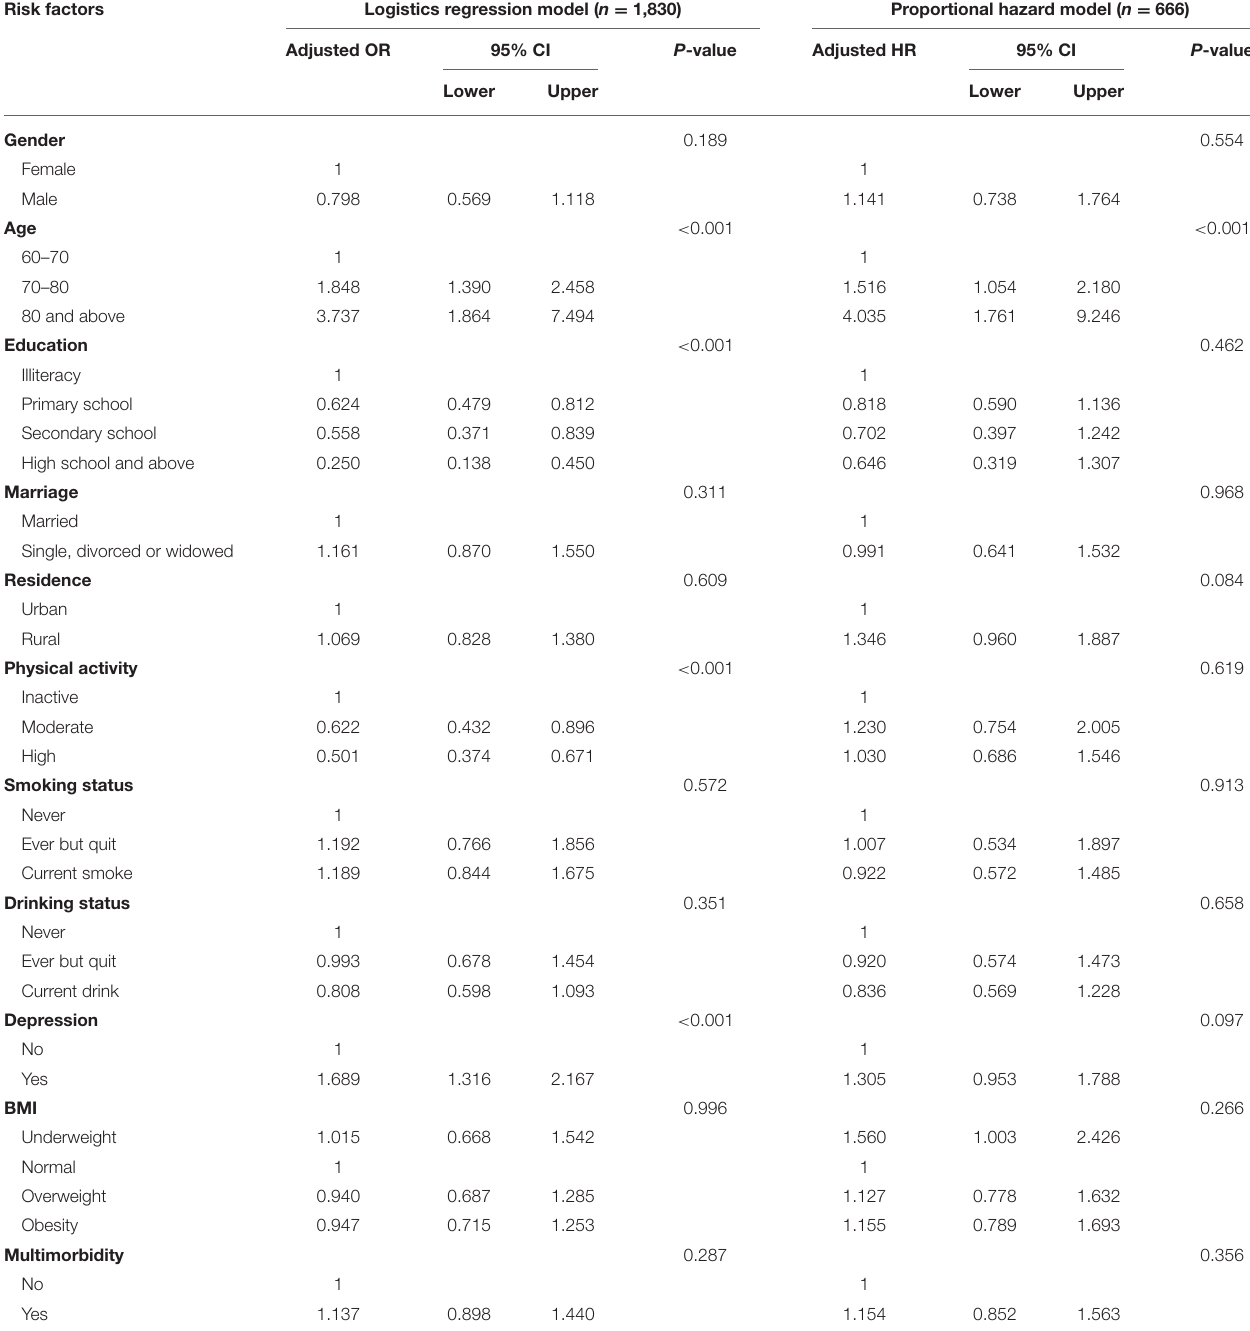
TABLE 2 | Risk factors of the prevalence and incidence of possible